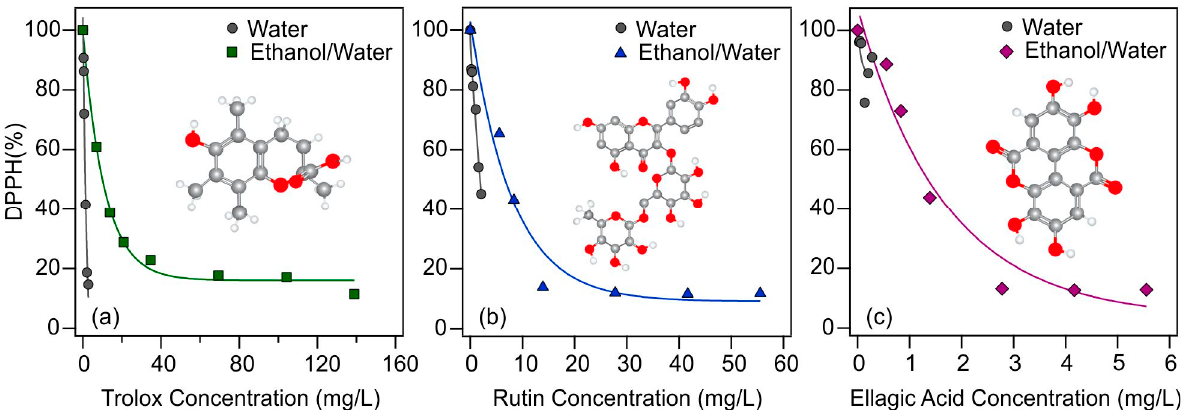
Figure 2. DPPH scavenging activity of antioxidants (trolox ( a ); rutin ( b ); and ellagic acid ( c )) as a function of their actual concentration in the assays using different solvents (water (gray circles for all) and ethanol/water (green squares, blue triangles, and purple diamonds, respectively)) in the stock solutions of the antioxidants. The solid lines are mathematical functions used to calculate the EC 50 values.